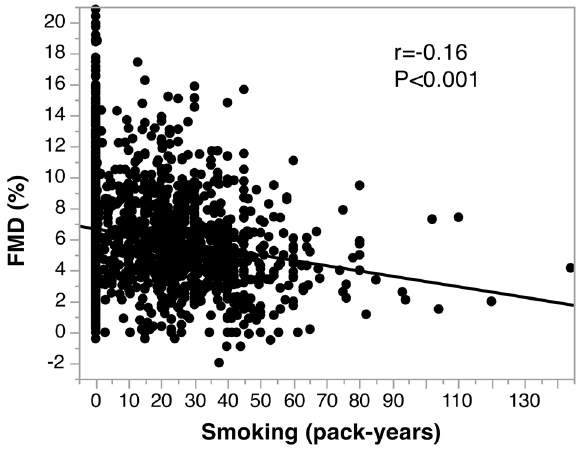
Figure 1. Scatter plots show the relationships between flow-mediated vasodilation (FMD) and smoking status in current smokers in men.